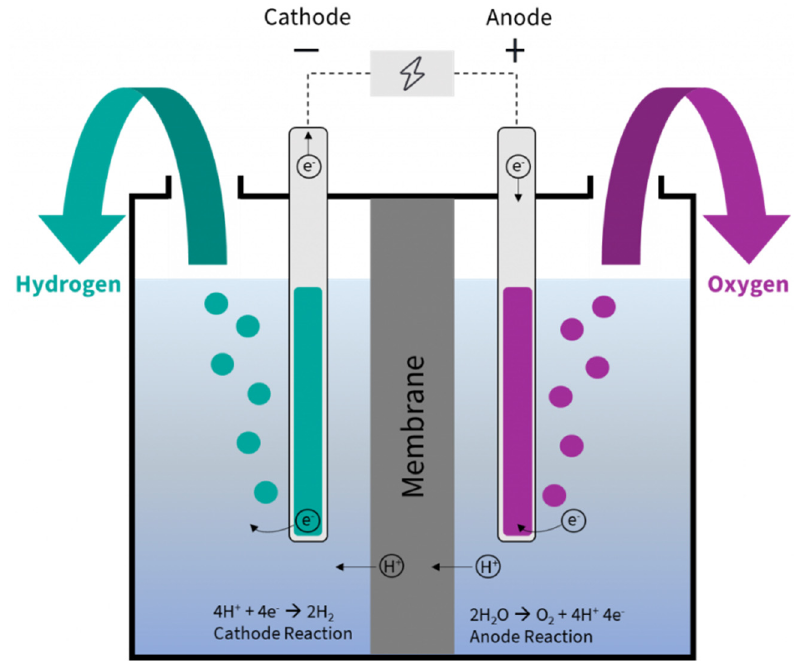
Figure 4. Simplified scheme of the water electrolysis process [21].